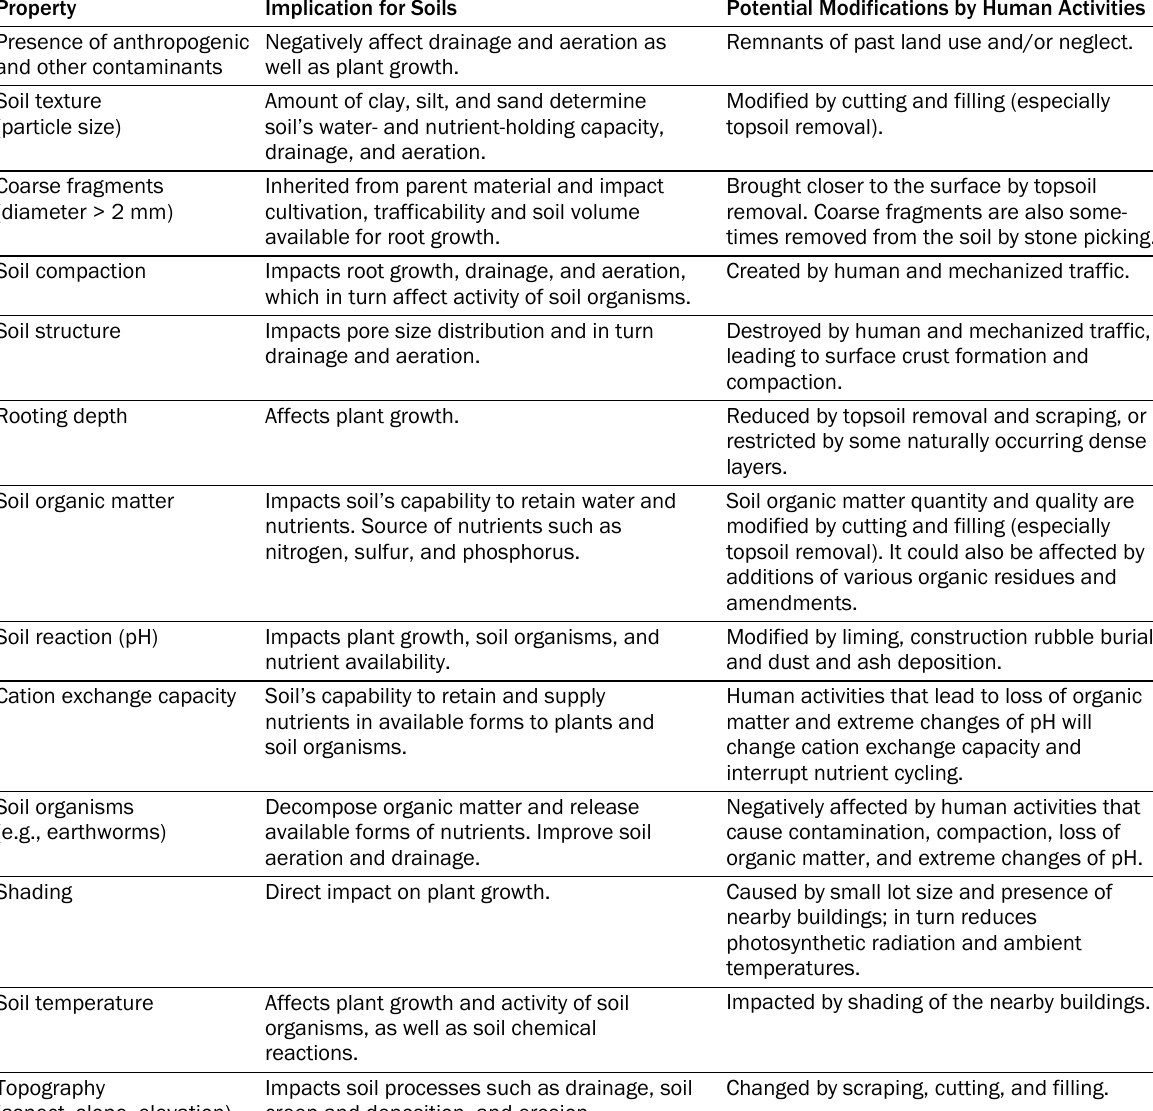
Table 2. Site Characteristics of Relevance to Urban Soil Assessment in the City of Vancouver,